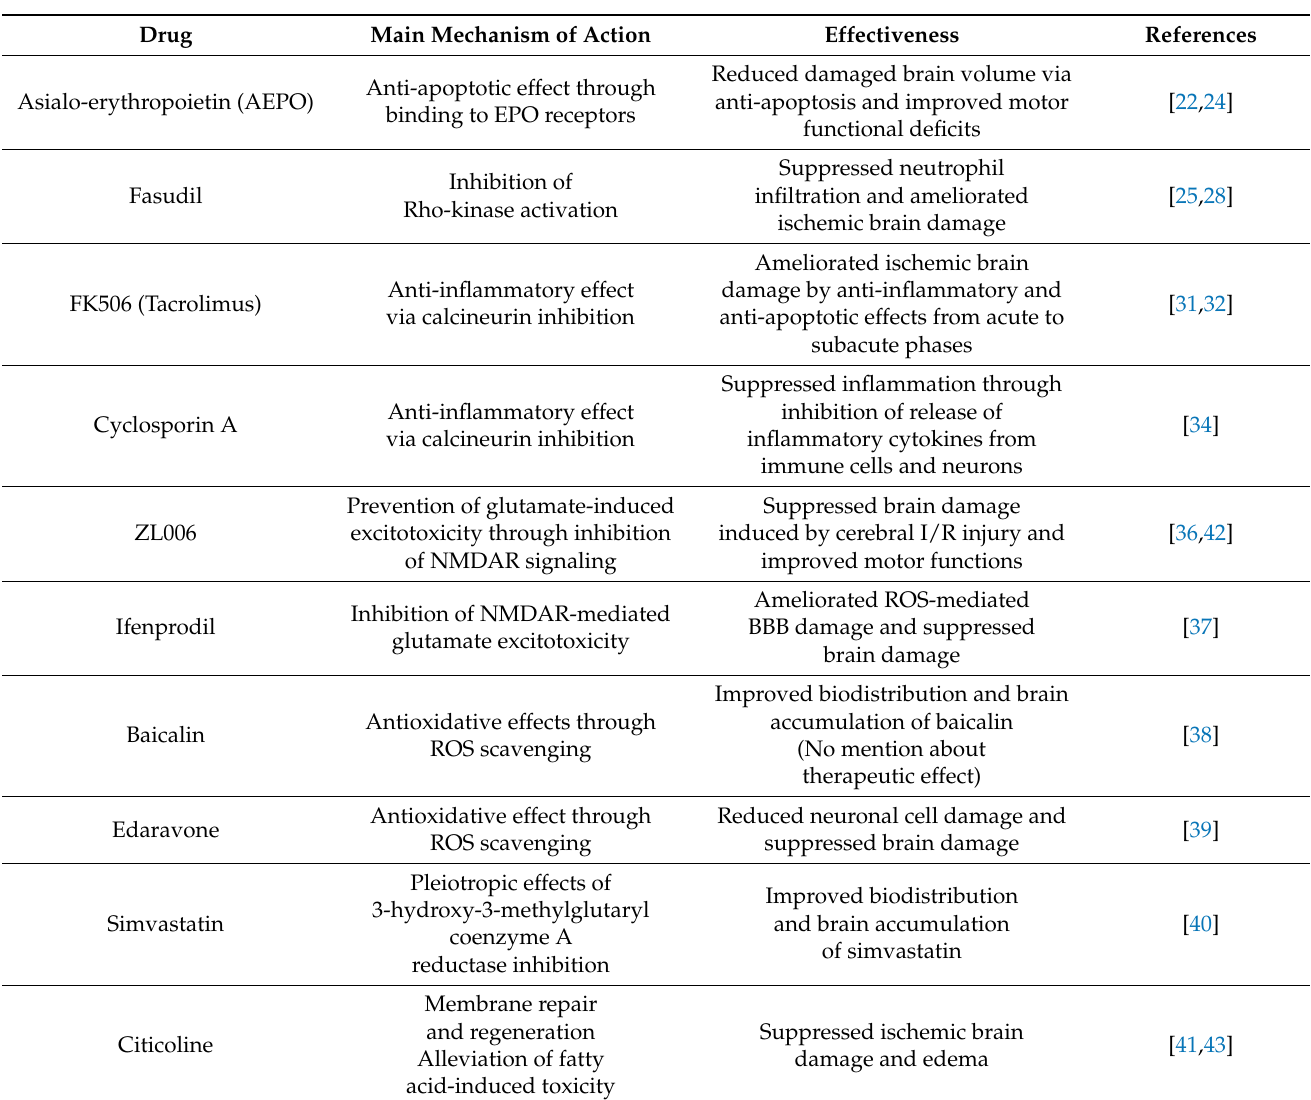
Table 1. List of liposomal neuroprotective agents for the treatment of ischemic stroke (described in this